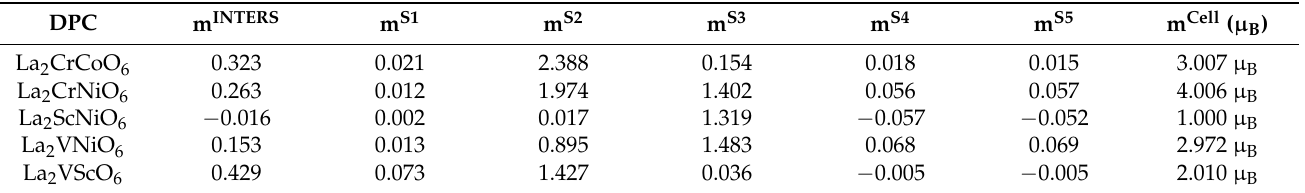
Table 3. Calculated spin magnetic moments of DPCs Using Generalised gradient approximation with hybrid term (GGA+U).